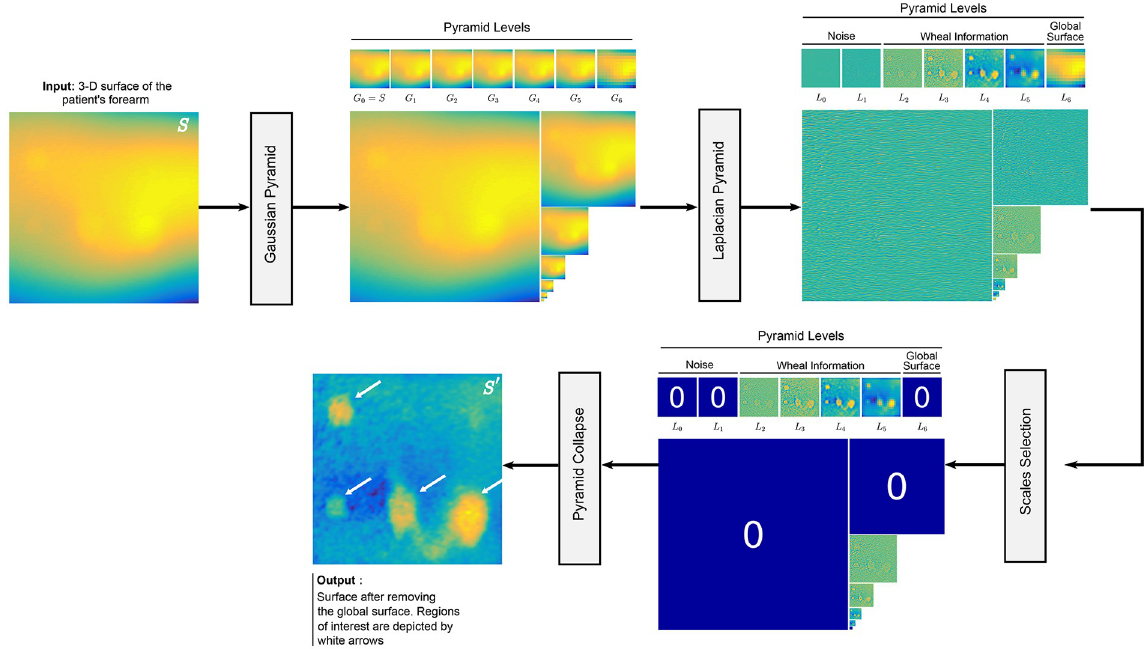
Fig 5. The Global Surface Removal stage. S and S 0 denote the 3D surface of the patient’s forearm and the surface after removing the global curvature of the forearm, respectively. The other variables are intermediate outputs of every sub-stage; their meaning is given in the